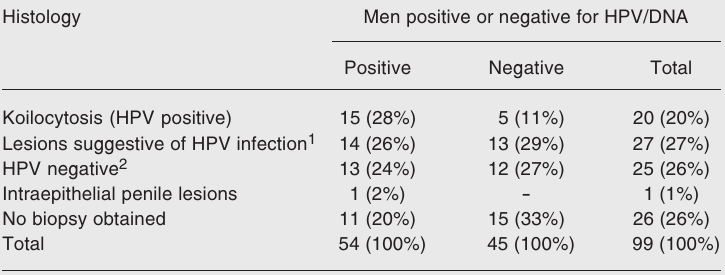
Table 2. Number and percentage (in parentheses) of men positive or negative for human papillomavirus (HPV) DNA and the histological type of their lesions when examined by